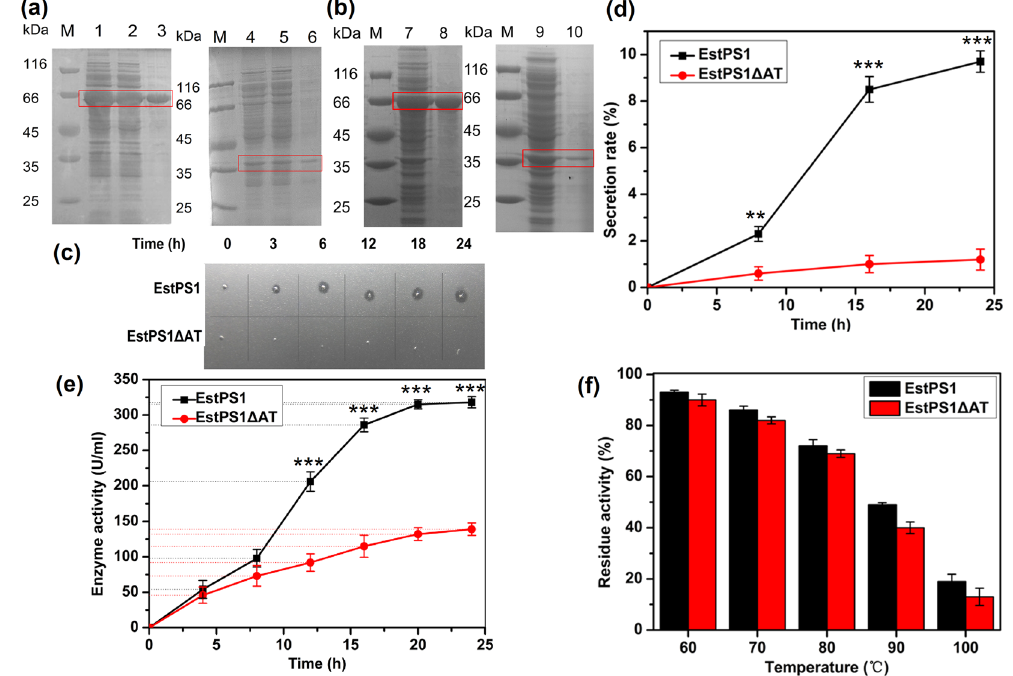
Figure 3. Role of the AT domain in recombinant EstPS1. ( a ) SDS-PAGE analysis of EstPS1 and EstPS1 Δ AT. lane M - standard marker proteins; lane 1,2 - supernatant of cell lysate (EstPS1); lane 3 - purified protein of EstPS1; lane 4,5 - supernatant of cell lysate (EstPS1 Δ AT); lane 6 - purified protein of EstPS1 Δ AT. ( b ) SDS-PAGE analysis of EstPS1 Δ SP and EstPS1 Δ SP + AT. lane M - standard marker proteins; lane 7 - crude extracts of EstPS1 Δ SP; lane 8 - purified protein of EstPS1 Δ SP (inclusion bodies); lane 9 - crude extracts of EstPS1 Δ SP + AT; lane 10 - purified protein of EstPS1 Δ SP + AT (inclusion bodies). ( c ) Transparent zones of EstPS1 and EstPS1 Δ AT in the solid induction medium at different hours. ( d ) Effect of the AT domain on secretion rate at 0 h, 8 h, 16 h, and 24 h. Secretion rate is defined as the enzyme activity of culture medium in proportion to the total activity. Data represent mean ± SD (n = 3); * p < 0.05, ** p < 0.01, *** p < 0.001